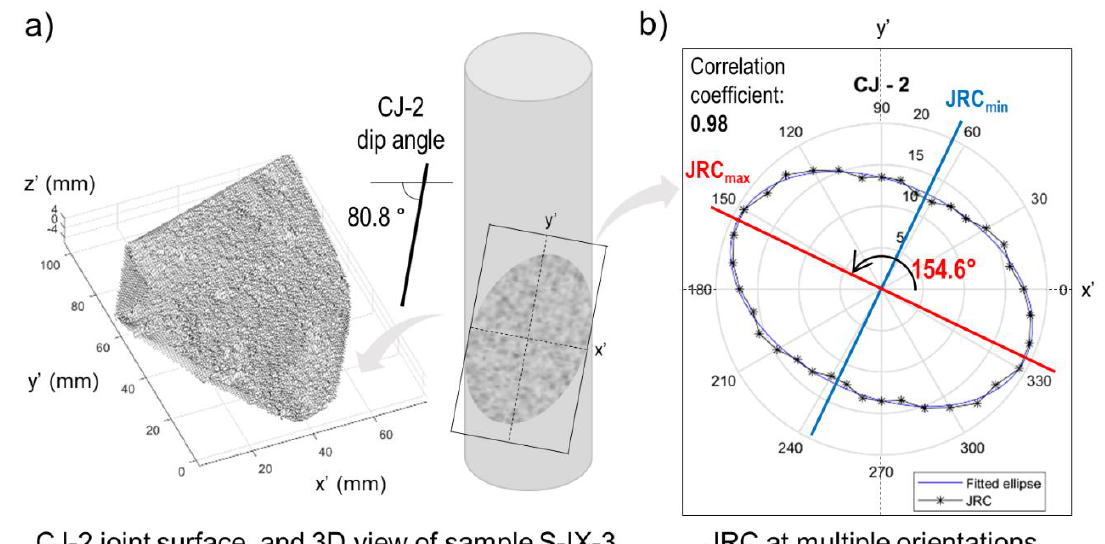
Figure 5. ( a ) Wireframe representation of CJ-2 joint on relative plane x′-y′, and schematic of sample S-IX-3 showing joint CJ-2 location. ( b ) Results of JRC measurements carried out using multiple parallel cross sections at 10 degrees increments. The mean value per orientation was then plotted in the polar diagram. To refine the anisotropy estimation, an ellipse fitting process was implemented (correlation coefficient 0.98), from which the orientations of JRC max and JRC min were obtained on the joint relative plane (dip angle 80.8°).